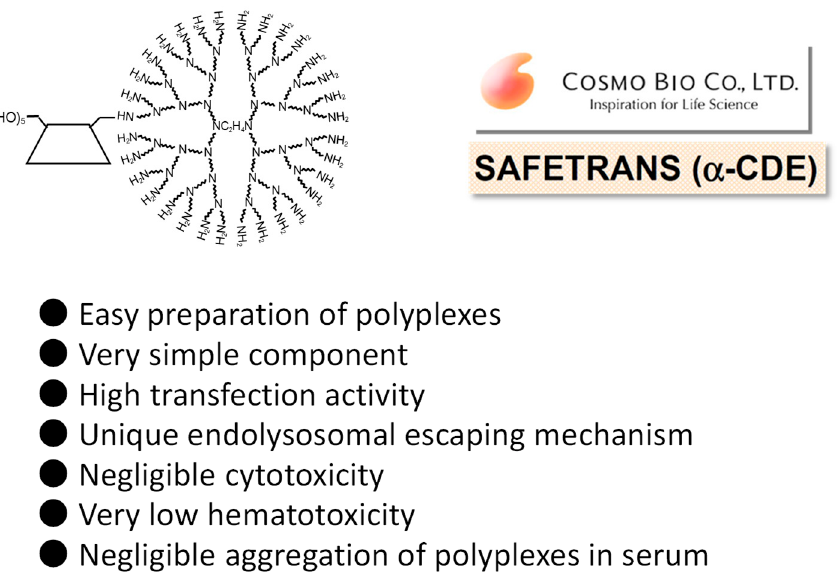
Figure 4. Excellent properties of α -CDE (G3) as a carrier of pDNA, oligonucleotides, and other drugs.